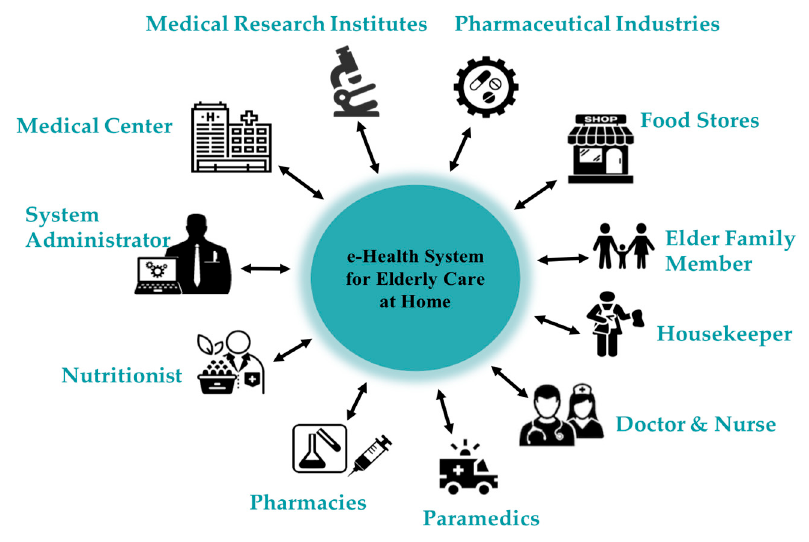
Figure 2. Context view.